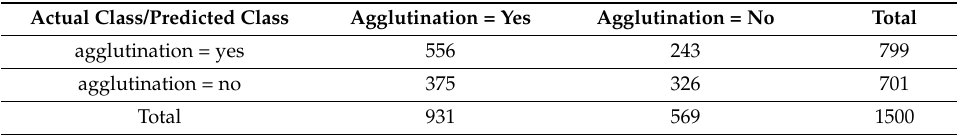
Table 5. Confusion matrix for the SDS over the 1500 patches.